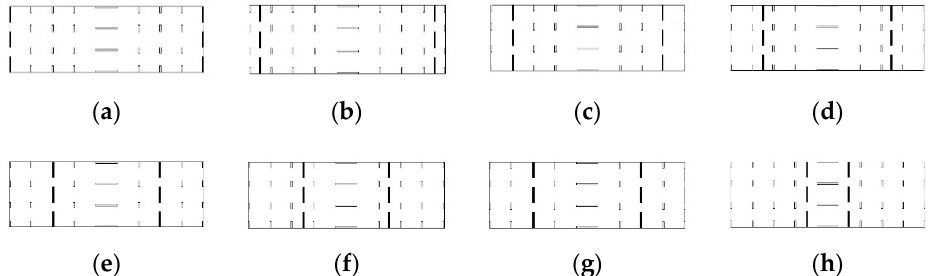
Figure 2. Building plans for first group of parametric study (with b/r = 1.1): ( a ) Building frequency ratio Ω = 1.4; ( b ) Building frequency ratio Ω = 1.3; ( c ) Building frequency ratio Ω = 1.2; ( d ) Building frequency ratio Ω = 1.1; ( e ) Building frequency ratio Ω = 1.0; ( f ) Building frequency ratio Ω = 0.9; ( g ) Building frequency ratio Ω = 0.8; ( h ) Building frequency ratio Ω = 0.7.